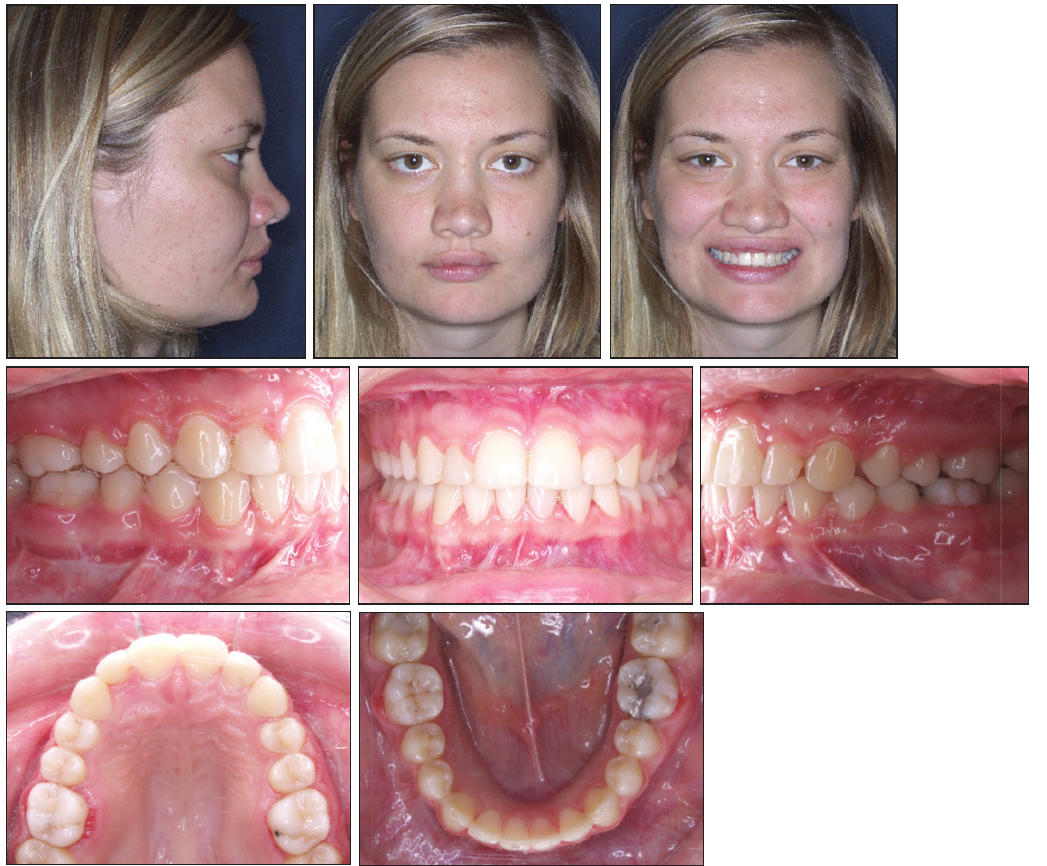
Figure 3a. Post-treatment